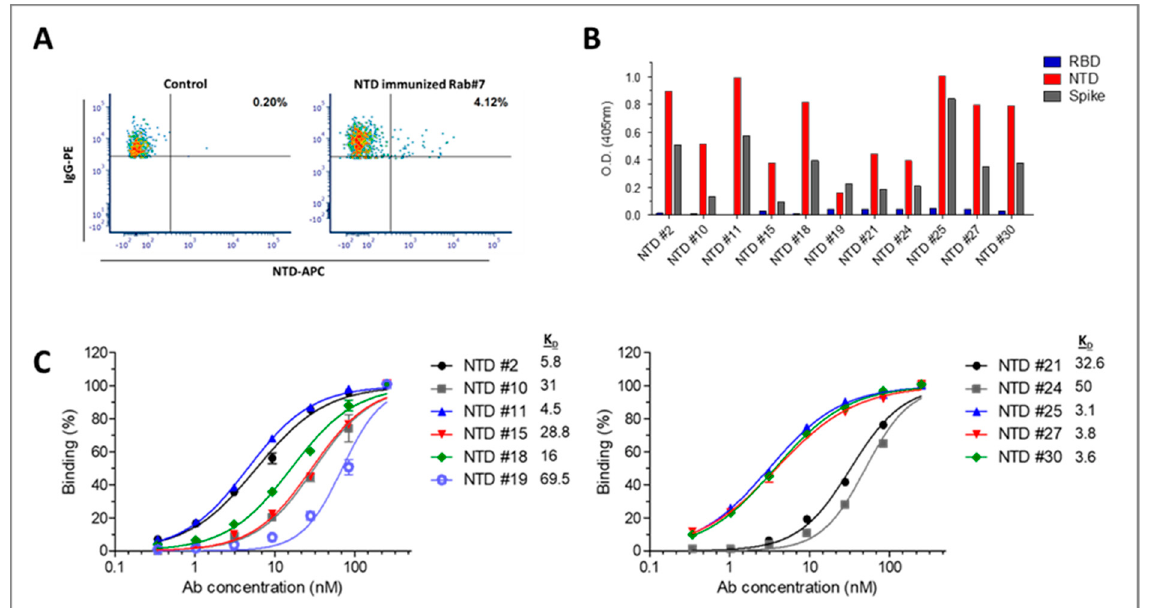
Figure 5. Isolation and Characterization of anti-NTD antibodies. ( A ) Splenocytes were isolated from huFc-NTD-immunized rabbit 7 and were analyzed by flow cytometry using anti IgG-PE and APC fluorescence conjugated antigens NTD. IgG + /APC-NTD + B cells (located at the upper right quadrant and represented as percent out of total IgG+ cells) were single-cell sorted into 96-well microplates by FACSAria. Naïve rabbit PBMCs were analyzed as a negative control, demonstrating the specificity of the sorting strategy. ( B ) Specificity of the anti-NTD antibodies was determined by ELISA against the indicated SARS-CoV-2 proteins. Results are averages of duplicates from representative experiment (out of two performed with similar results). ( C ) Binding profiles of the antibodies determined by ELISA using NTD as the coating antigen. Data presented as binding percent of B max for each antibody. The values represent average of triplicates ±SEM fitted by non-linear regression. The apparent K D (nM) value of each antibody is shown.